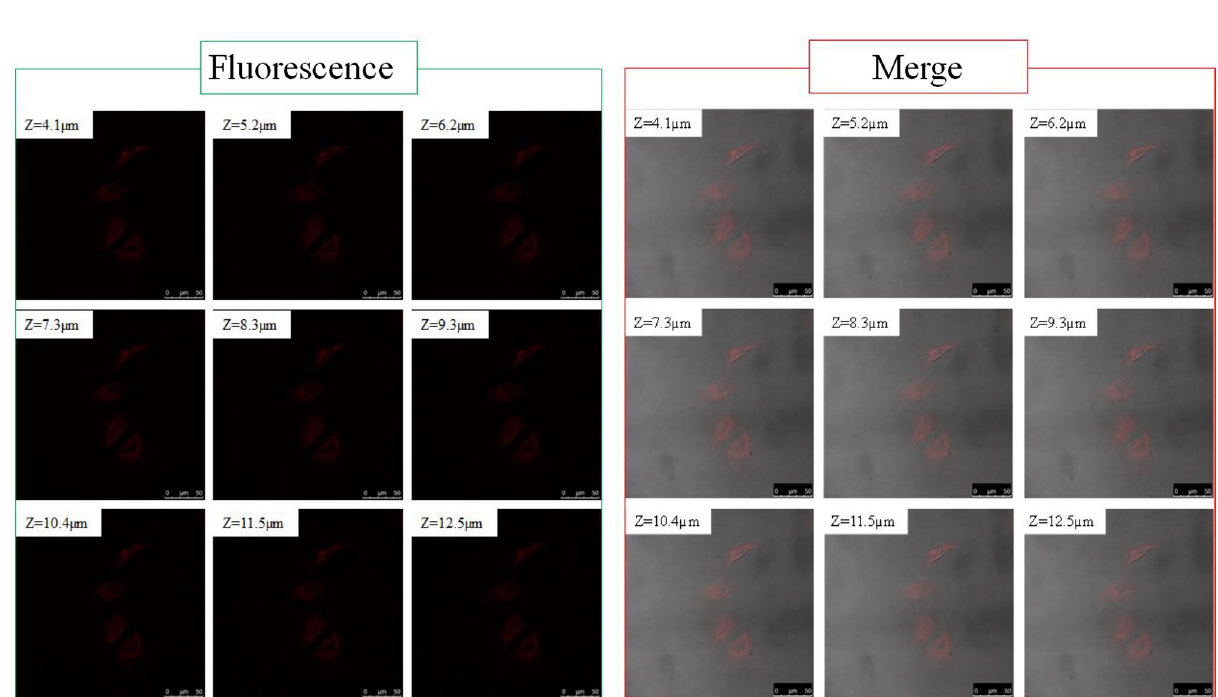
Figure 5. HeLa cellular uptake of UA-SiQDs with 11%-UA-coverage under confocal microscopy (Left: fluorescence. Right: overlap images). Slice scan of HeLa cells under confocal microscopy. Bar shows 50